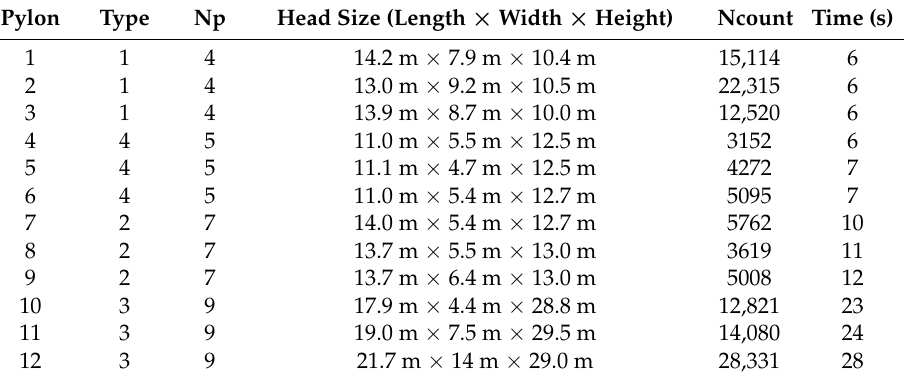
Table 8. The efficiency of Head